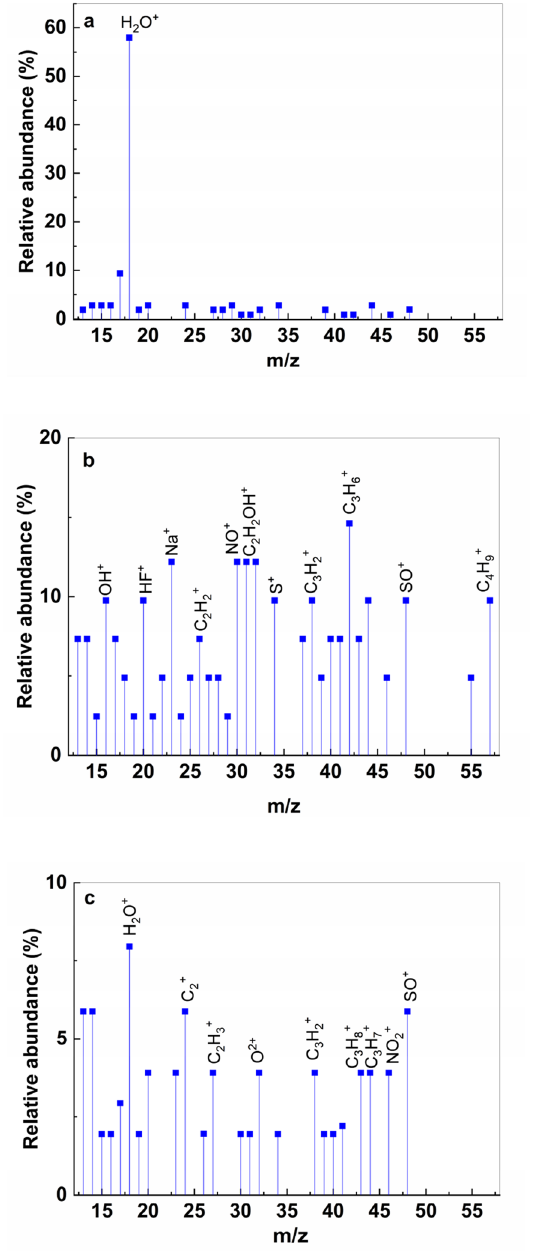
Figure 15. MS curves of PS ( 1 ) in dark conditions ( a ) and after exposure to UV light of PS ( 1 ) ( b ) and NaOH- reacted PS ( 1 ) ( c